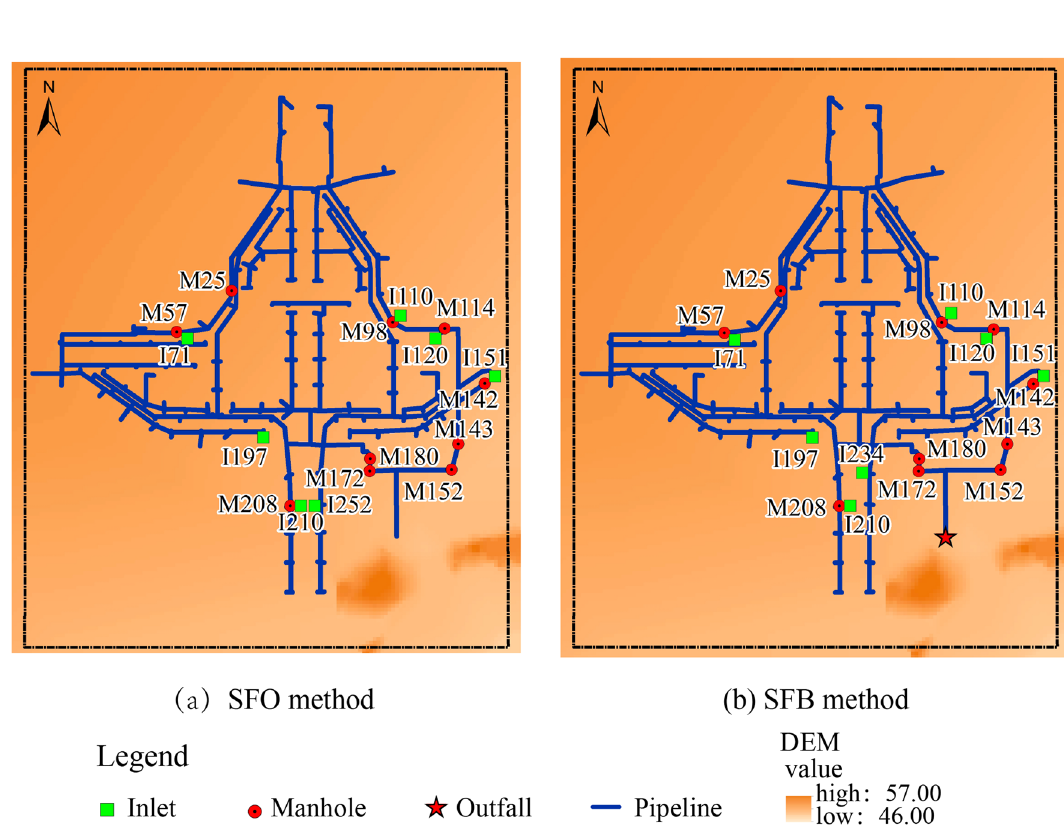
Figure 9. Overflow nodes of the SF